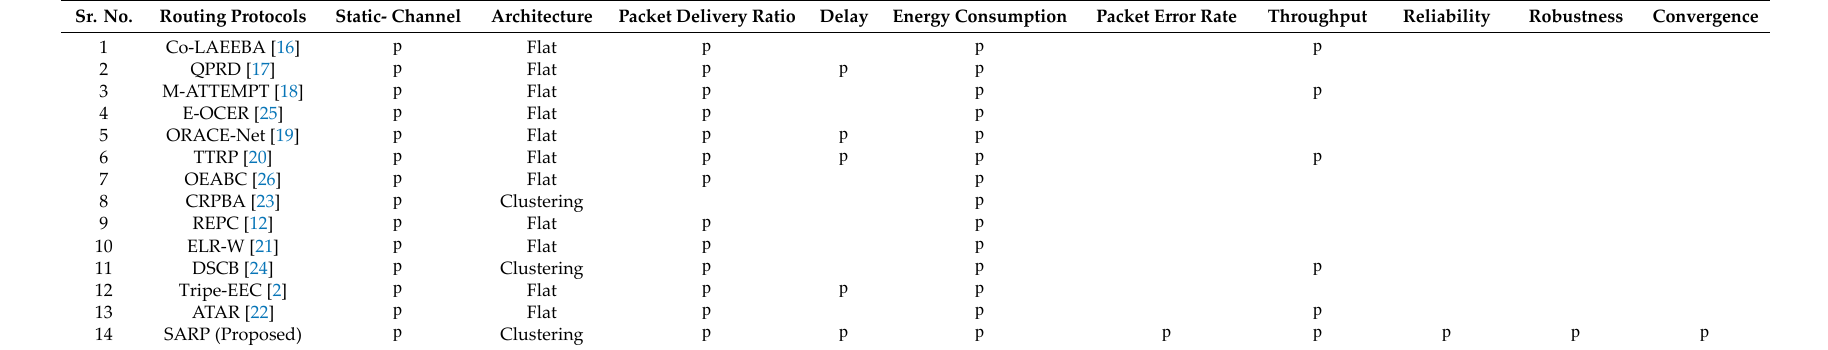
Table 1. Comparison of schemes in